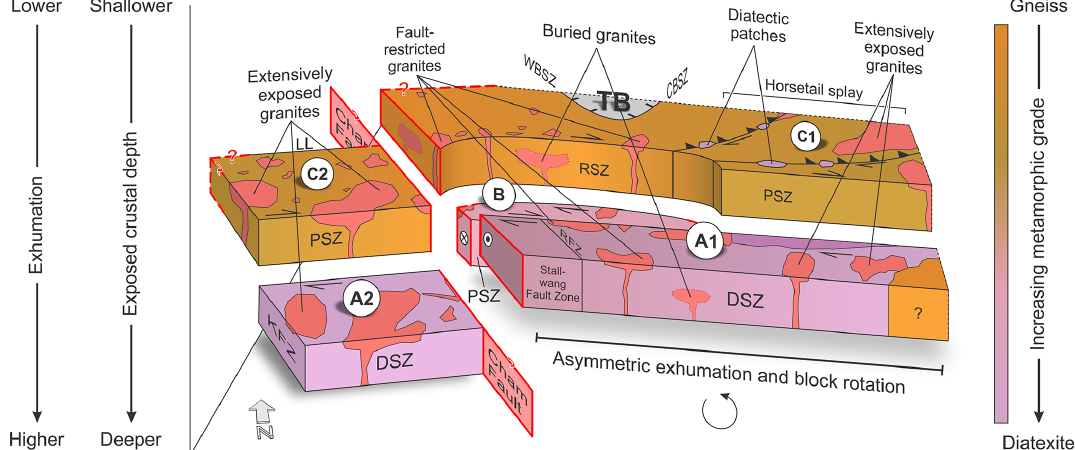
Figure 10. Proposed three-dimensional block model of the southwestern Bohemian Massif. Distinct fault zones separate blocks of different lithological, gravity, and topographic characters, pointing to the exposure of different crustal levels and, thus, to varying amounts of exhuma- tion, the latter increasing from domain C towards domain A. To the east of the Cham Fault, asymmetric exhumation has led to the tilting of the entire area towards the west. Note that the relative depth in the model shows the exposed crustal level. Fault zones: CBSZ –